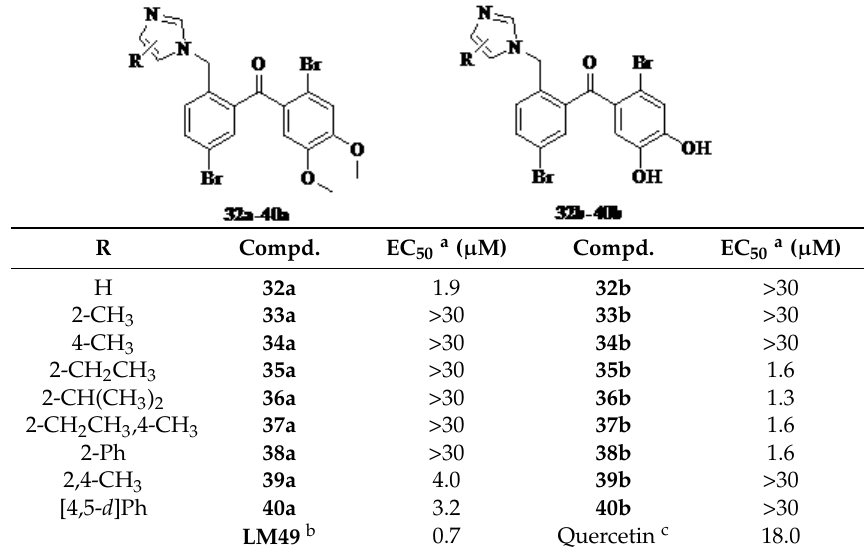
Table 3. Structures of imidazole compounds 32a – 40a , 32b – 40b and their cytoprotective activity against H 2 O 2 induced injury in EA.hy926 cells.